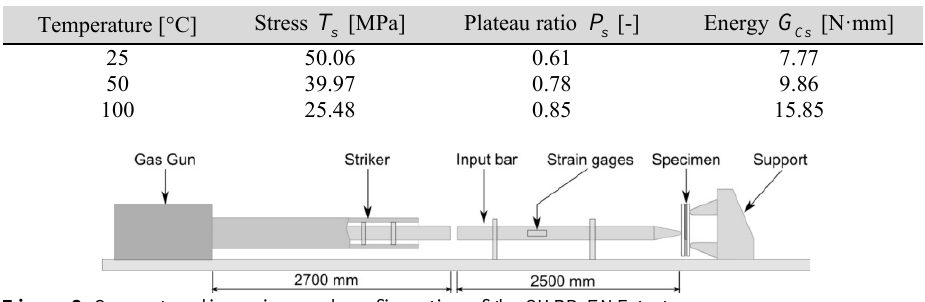
Table 1 . Calibrated model parameters of the traction separation law